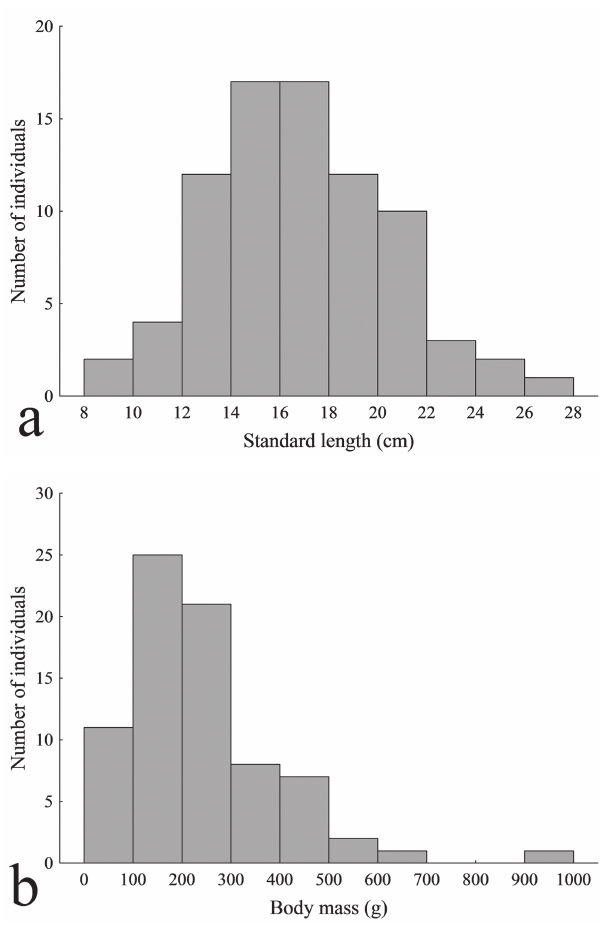
Fig. 2. Number of individuals of Mylesinus paucisquamatus within classes of standard length (a, centimeters) and total weight (b, grams), upper rio Tocantins.